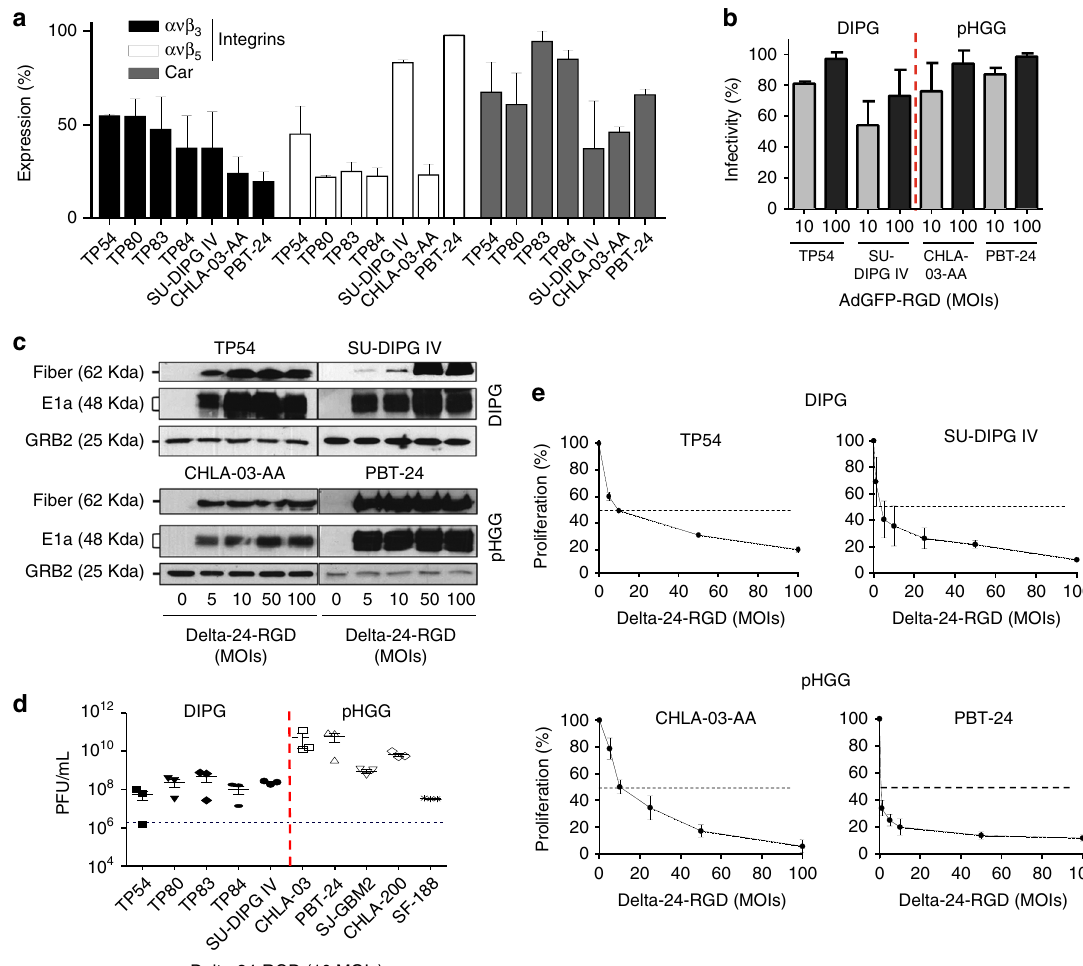
Fig. 2 Delta-24-RGD exerts a potent oncolytic effect in DIPG and pHGG cell lines. a Flow cytometry analyses of CAR and integrin expression. DIPG and pHGG cell lines were incubated with fl uorescent antibodies against α ν β 3 and α ν β 5 integrins and CAR. The data are shown as the relative percentage (mean ± SD) of positive expression scored among 10,000 cells. b Assessment of infectivity in DIPG and pHGG cell lines. The indicated cell lines were infected with a replication-de fi cient construct expressing a modi fi ed fi ber knob (AdGFP-RGD). The data are shown as the relative percentage (mean ±SD) of GFP-positive cells scored among 10,000 cells per treatment group. c Assessment of viral protein expression in pHGG and DIPG cell lines infected with Delta-24-RGD by western blotting. One representative blot is shown of three independent experiments. d Quanti fi cation of Delta-24-RGD replication in the indicated cell lines. Viral titers were determined three days after infection at an MOI of 10 (10 6 pfu/ml) by an anti-hexon staining-based method in 293 cells and expressed as plaque-forming units (pfu) per milliliter. The dashed line indicates the input virus. The data are shown as the mean ± SD of three independent experiments. e Cell proliferation analyses of Delta-24-RGD-infected DIPG and pHGG cell lines. Cell viability was assessed using MTS assays 5 days after infection. The data are shown as the percentage (mean± SD of three independent experiments) of cells alive after infection with Delta-24-RGD at the indicated multiplicities of infection (MOIs) relative to the non-infected cells (control, equal to 100%). Source data are provided as a Source Data fi